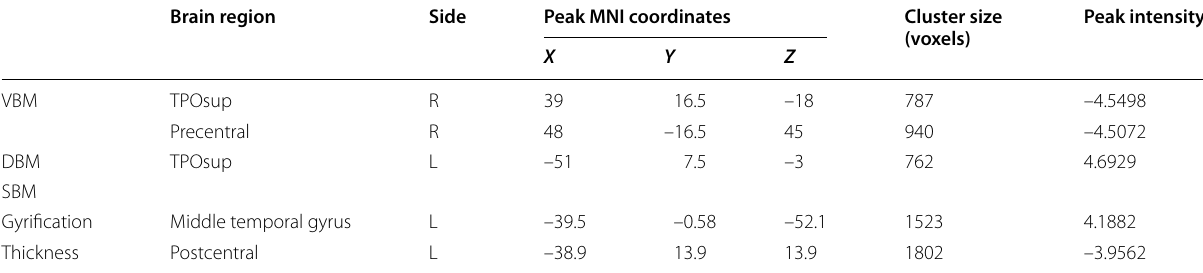
Table 2 Brain regions in which the GMV or cortex shape changed in patients compared with healthy controls, as detected using VBM, DBM, and SBM